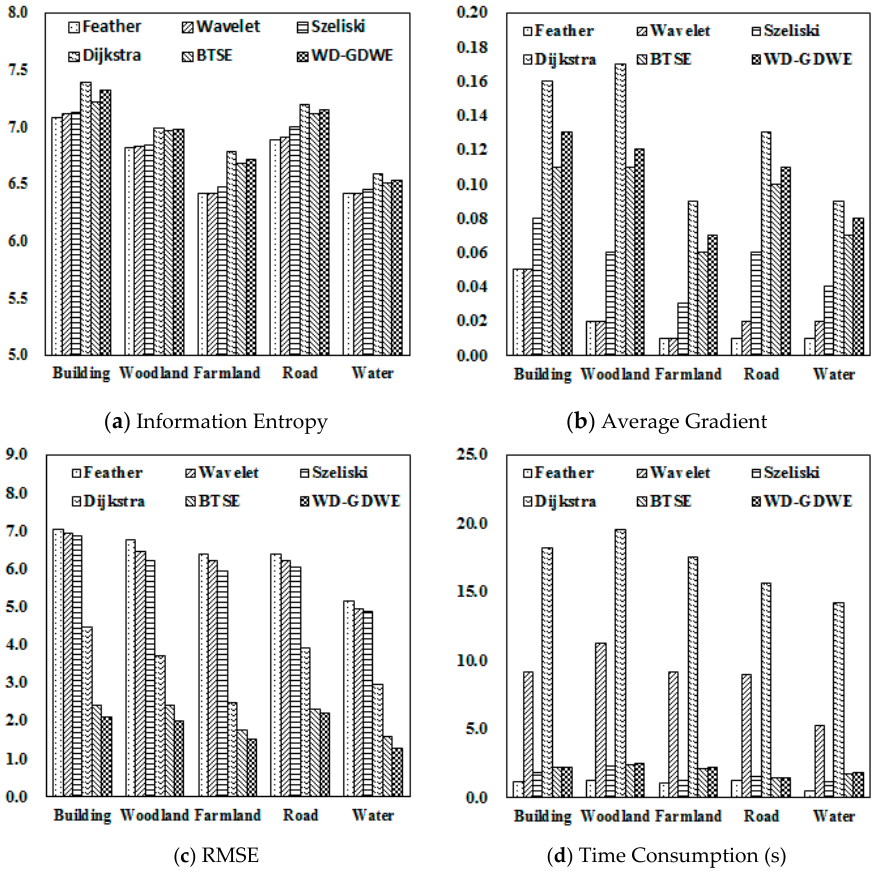
Figure 4. Comparisons of different elimination seam algorithms. ( a ) Information entropy for describing the amount of information; ( b ) verage gradient to access the image qualities; ( c ) RMSE between the specific five methods with the orthoimages; ( d ) time consumption of the six methods.